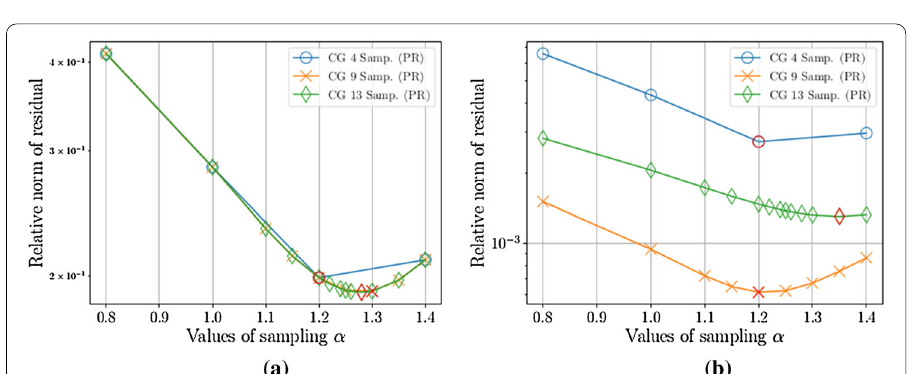
Fig. 6 Influence of the line search sampling iteration 0 ( a ) and iteration 3 ( b ). 9 sampling points achieve